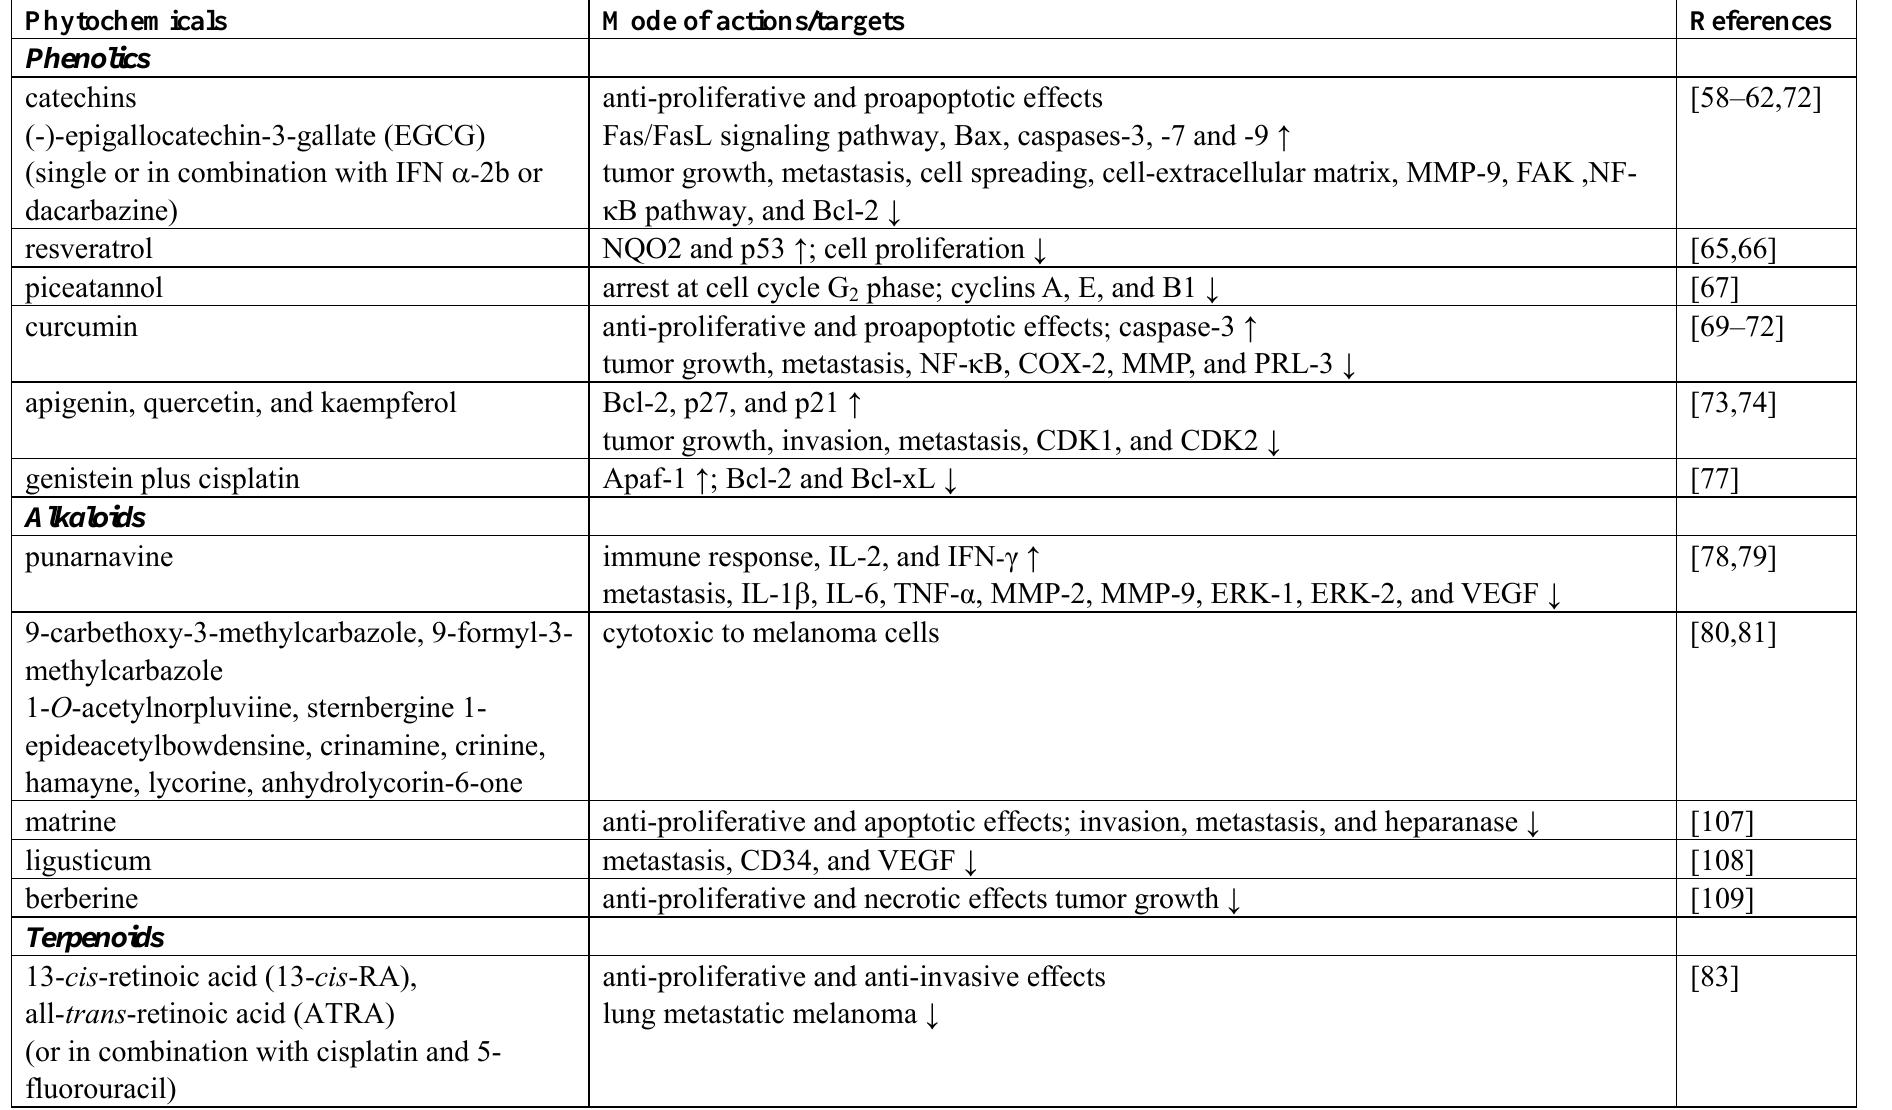
Table 1. Natural phytocompounds and herbal medicines in the treatment of cutaneous